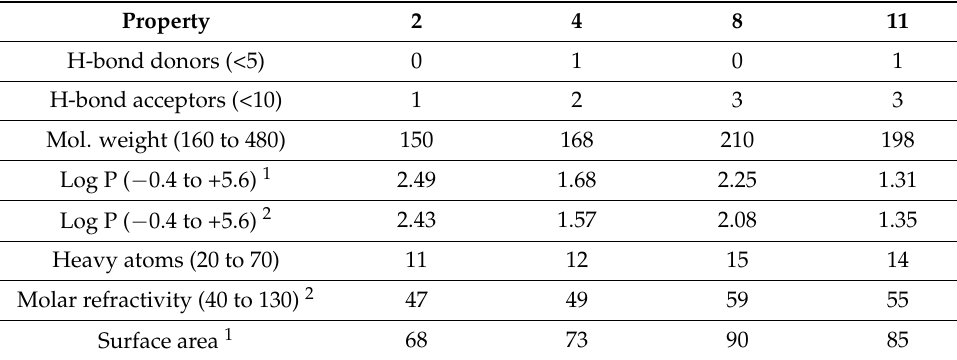
Table 2. Prediction of Lipinski’s rule of five (updated) parameters by the SwissADME and pkCSM